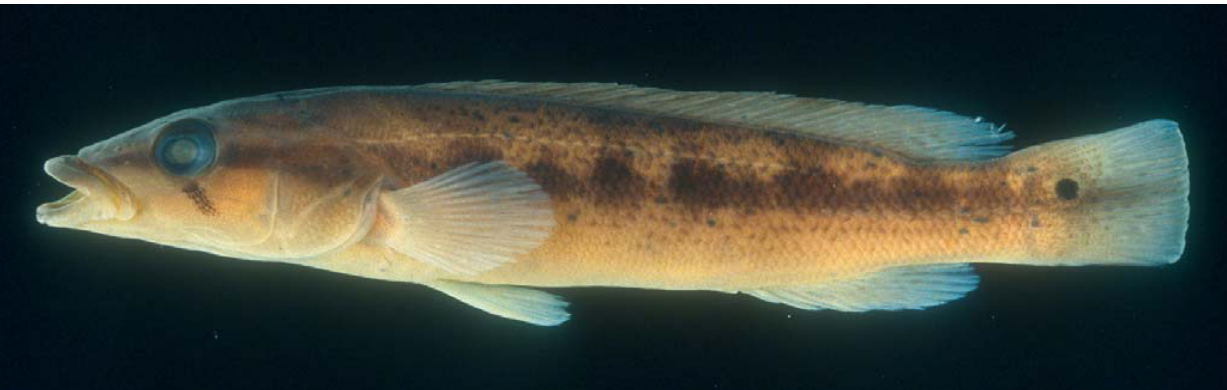
Fig. 8. Crenicichla maculata ,female, MCP 14661, holotype, 96.3 mm SL, Maquiné, rio Pinheiro, State of Rio Grande do Sul, Brazil.